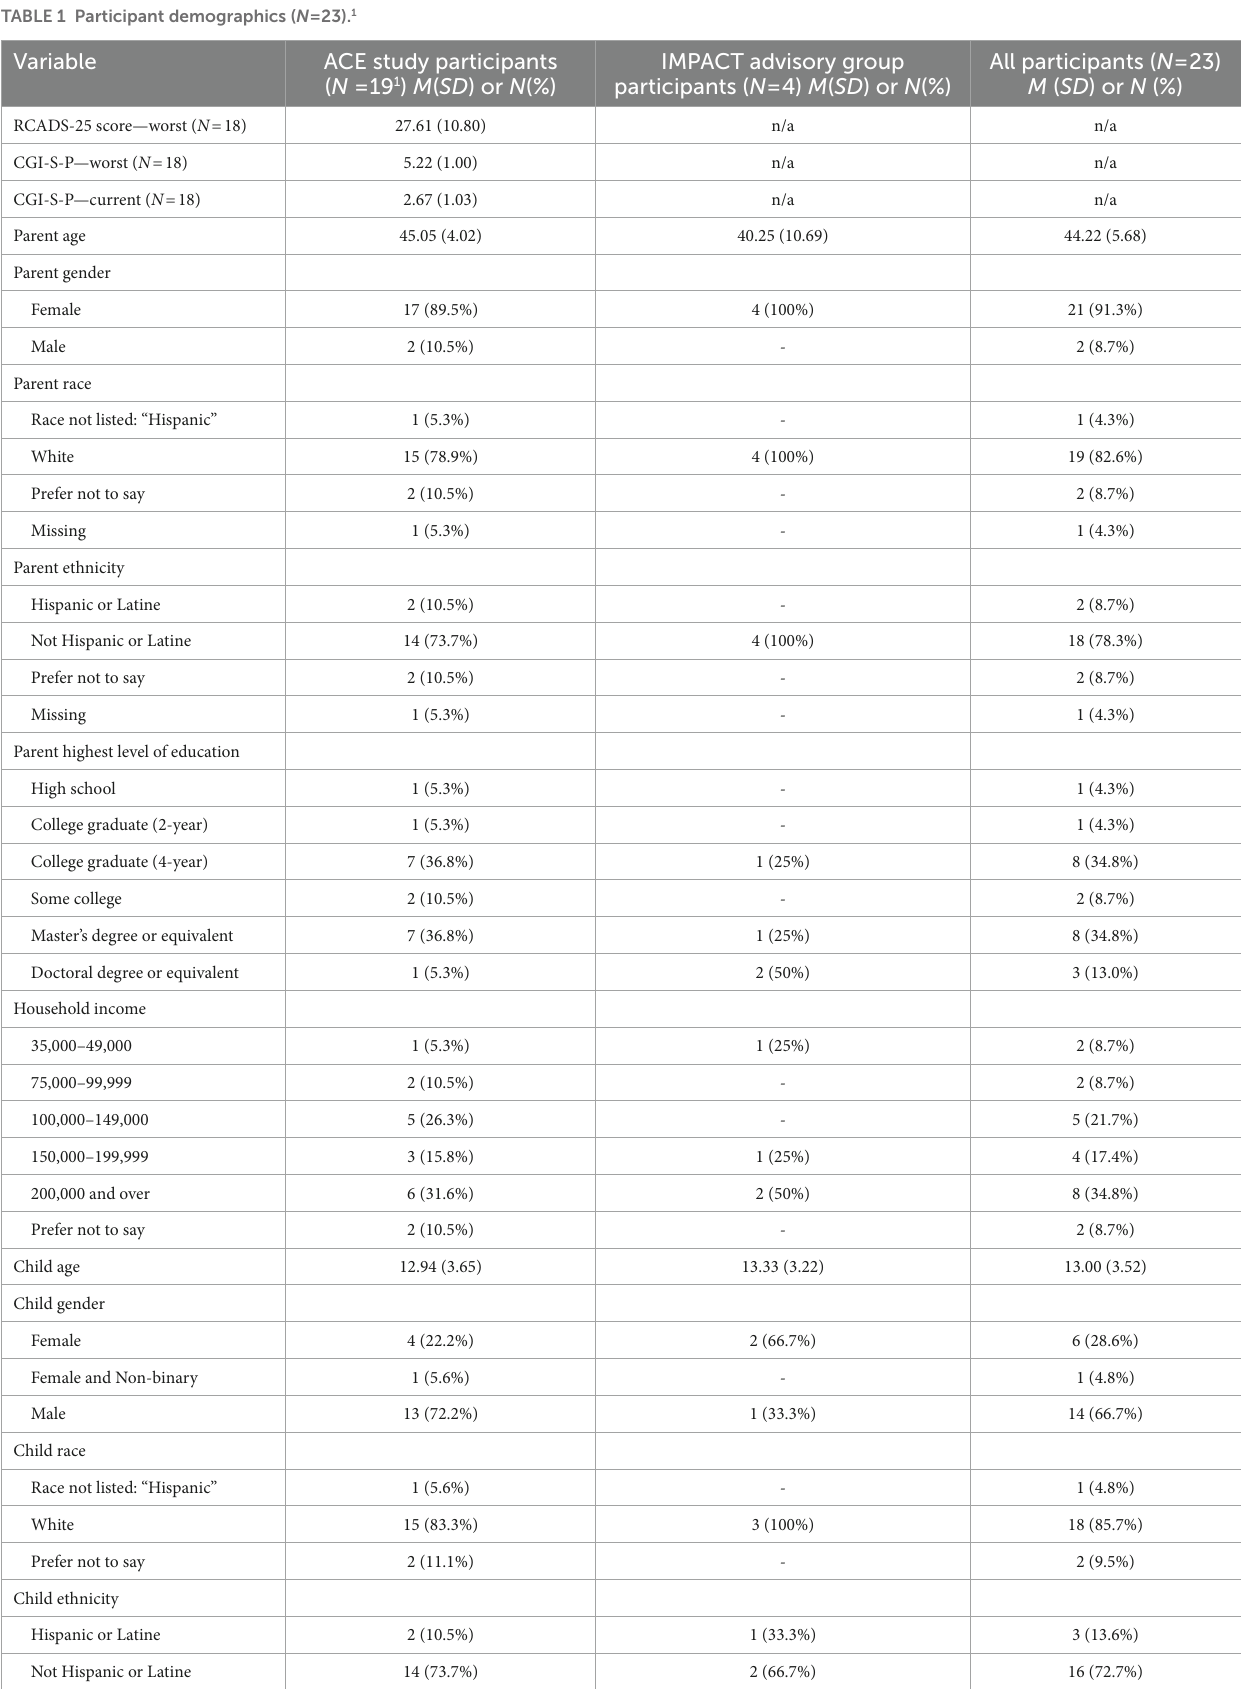
TABLE 1 Participant demographics ( N = 23). 1